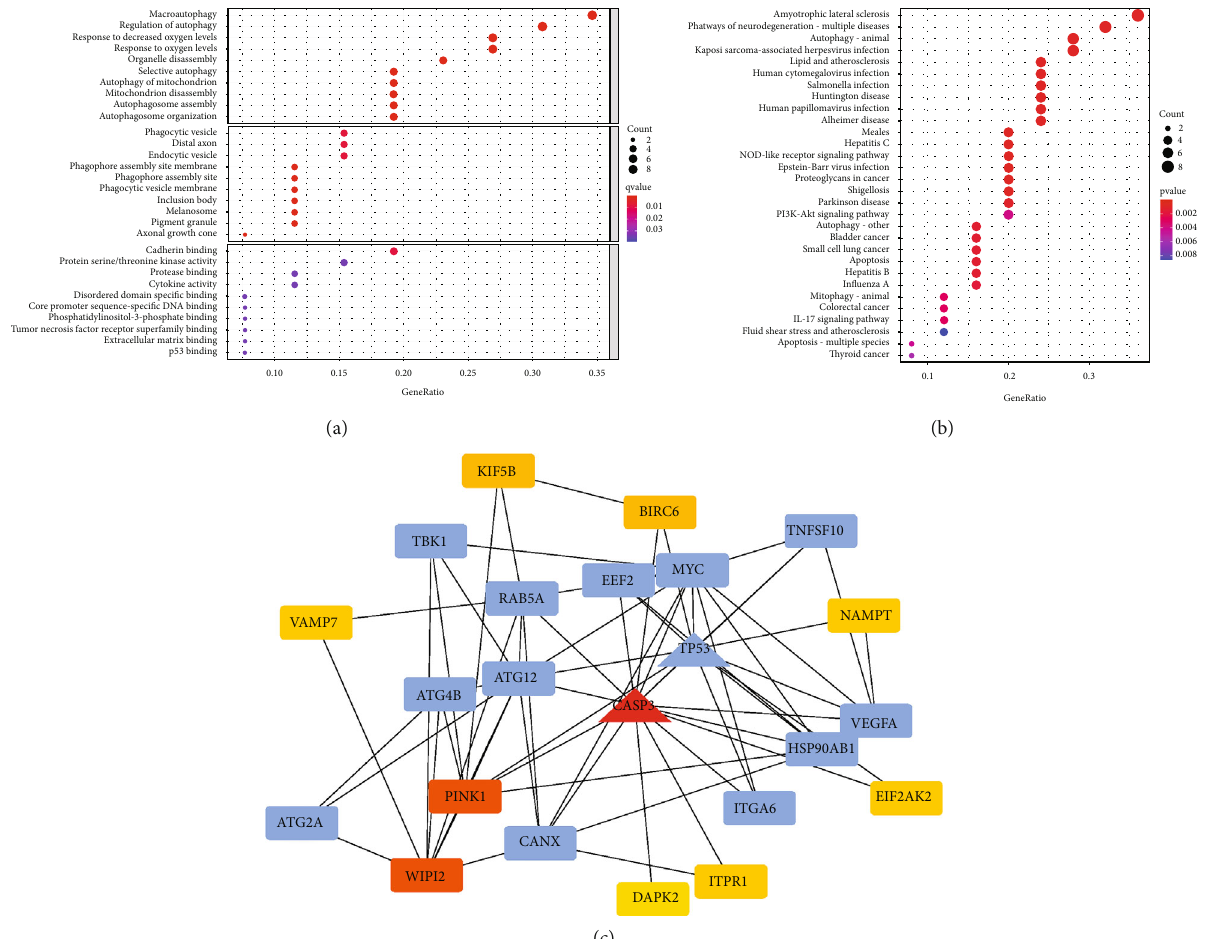
Figure 1: GO terms and KEGG pathways for enrichment analyses of OS-related ARGs in MM (adjusted P < 0 : 05 ). (a) OS-related ARGs were analyzed for signi fi cant enrichment using GO terms. (b) Signi fi cant enrichment analysis of OS-related ARGs using the KEGG pathway. (c) Two key modules (CASP3 and TP53) in OS-related ARGs were recognized by analyzing the protein-protein interaction network. The color of nodes in each module indicated their topology